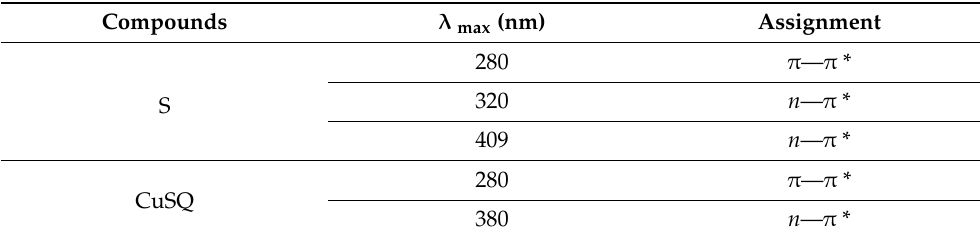
Table 3. Electronic spectra of Salen ligand and its CuSQ